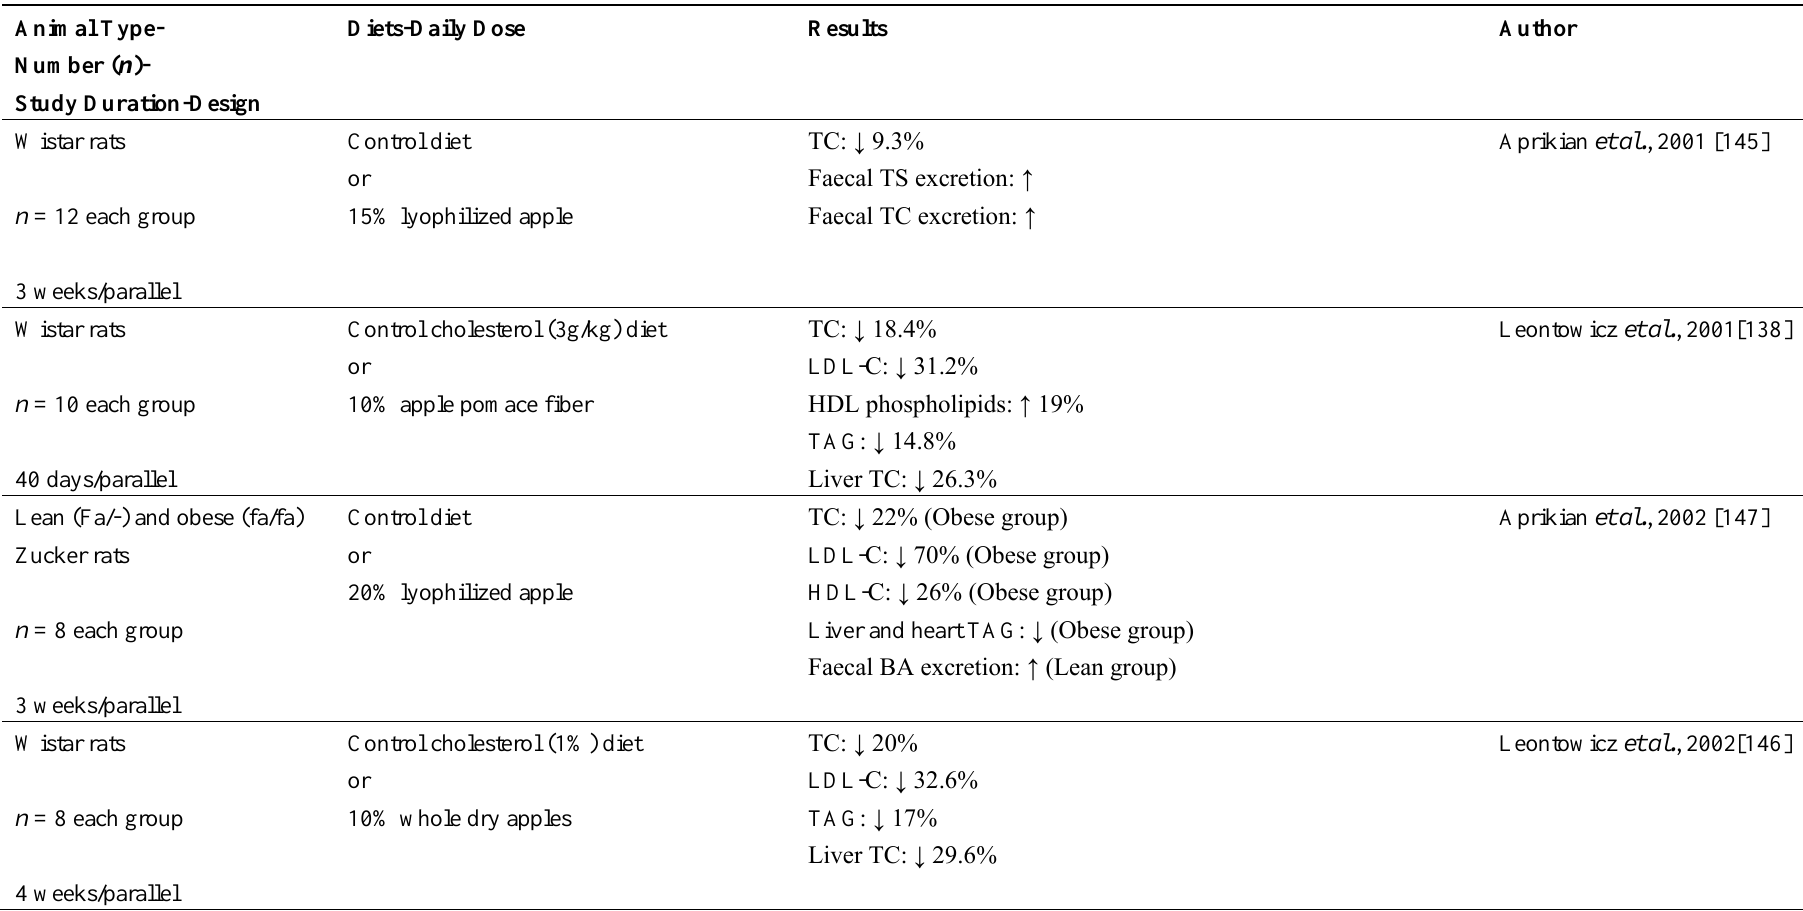
Table 3. Effects of apples and apple components on lipid metabolism in